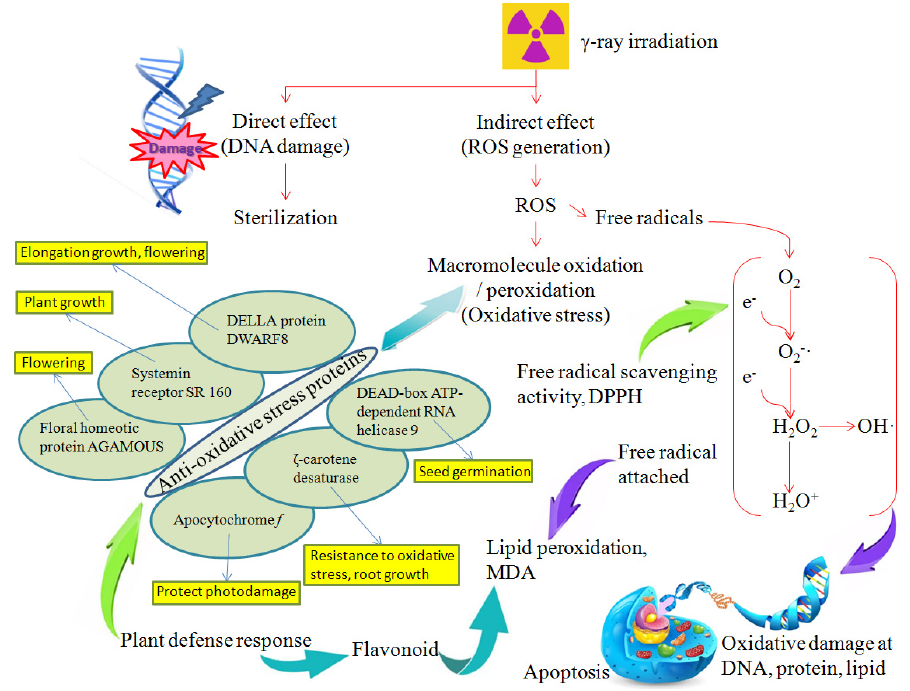
Figure 6. The effect of gamma-ray irradiation on the biological system of plant. Radiation can cause direct and indirect effects to DNA and proteins. For indirect effects, ROS are generated leading to increased oxidative stress and free radicals. In response to these radiation effects, flavonoid and anti-oxidative stress proteins are induced via this proposed mechanism.